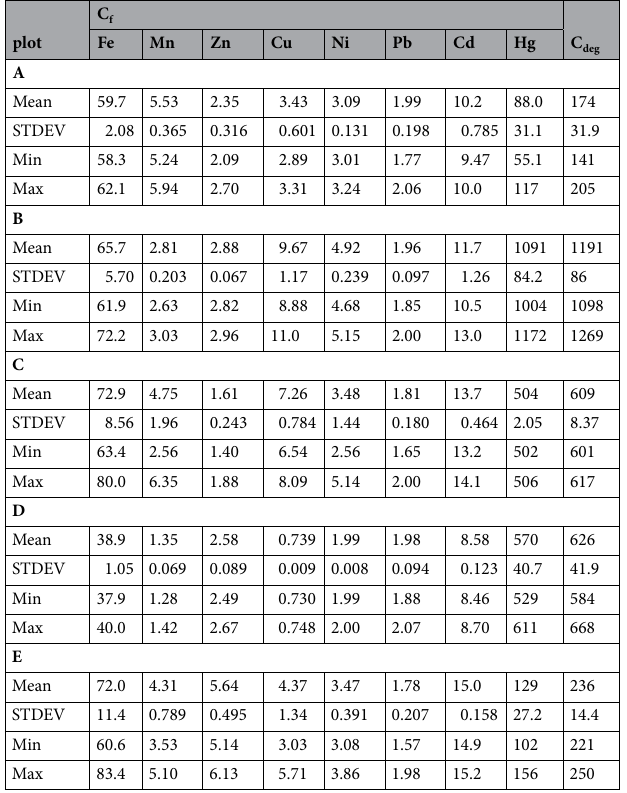
Table 4. Contamination factor (C f ) and degree of contamination (C deg ).